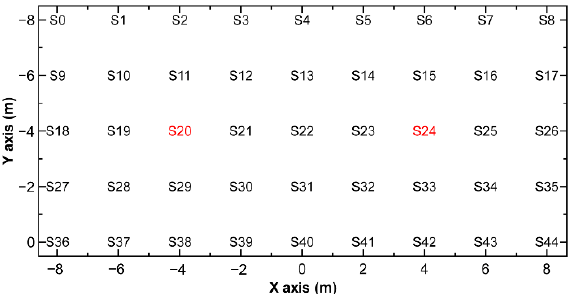
Figure 1. Locations of two-point sources and possible measurement positions around the sources on the search area in the integrated simulation model. The positions of the two sources are indicated in red.